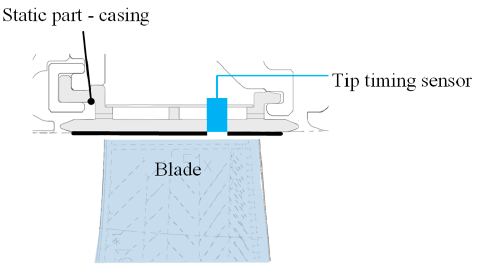
Figure 7. Design of a tip timing system.